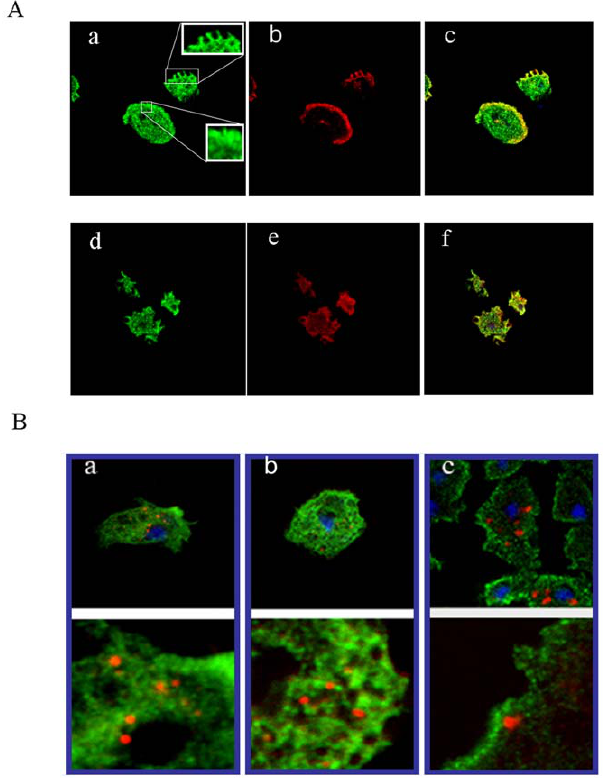
Figure 1. NDPK colocalises with actin and calmodulin, but not with macropinosomes. A. Wild type (AX2) Dictyostelium cells were immunostained with antibodies against NDPK, represented in green in panels a and d; actin, red in panel b; and calmodulin represented in red in panel e. The images were overlaid and association could be seen between NDPK and actin at the cell periphery in panel c and also between NDPK and calmodulin at the periphery and vacuoles in panel f. Insets in Panel A highlight enrichment of NDPK at the cell periphery and around vesicles and macropinosomic ruffles. B. Wild type (AX2) Dictyostelium cells in nutrient (HL-5) medium were pulsed with TRITC- dextran and chased for 0 minutes (panel a), 15 minutes (panel b) and 60 minutes (panel c). Cells were immunostained using antibodies against NDPK. TRITC-dextran fluorescence in macropinosomes is represented in red, NDPK immunofluorescence is shown in green and the nucleus is stained with DAPI, shown in blue. The lower part of each panel shows the NDPK localization and loaded macropinosomes at higher magni- fication.